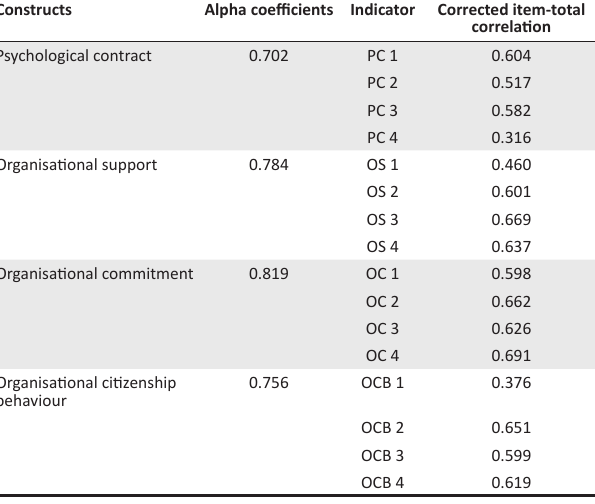
TABLE 1: Validity and reliability testing results. Constructs